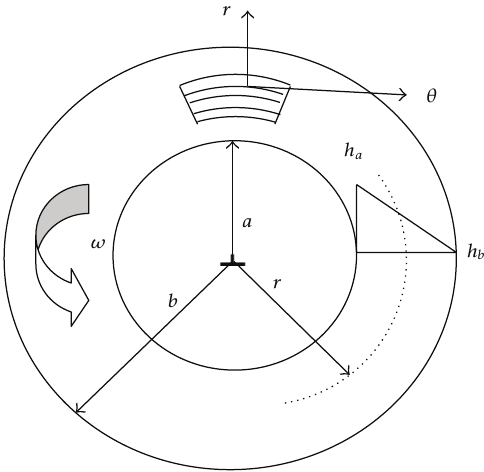
Figure 2: A rotating disc of linearly varying